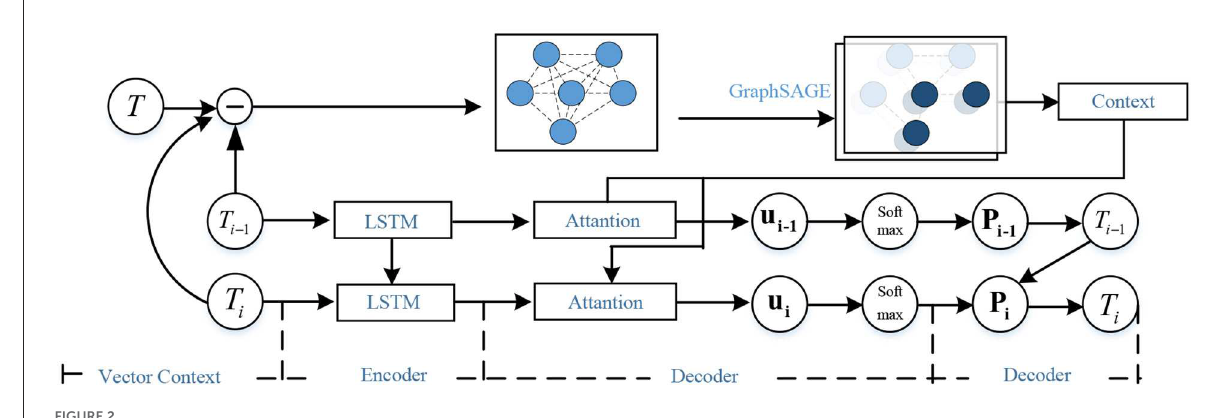
FIGURE2 GPN network structure model diagram.